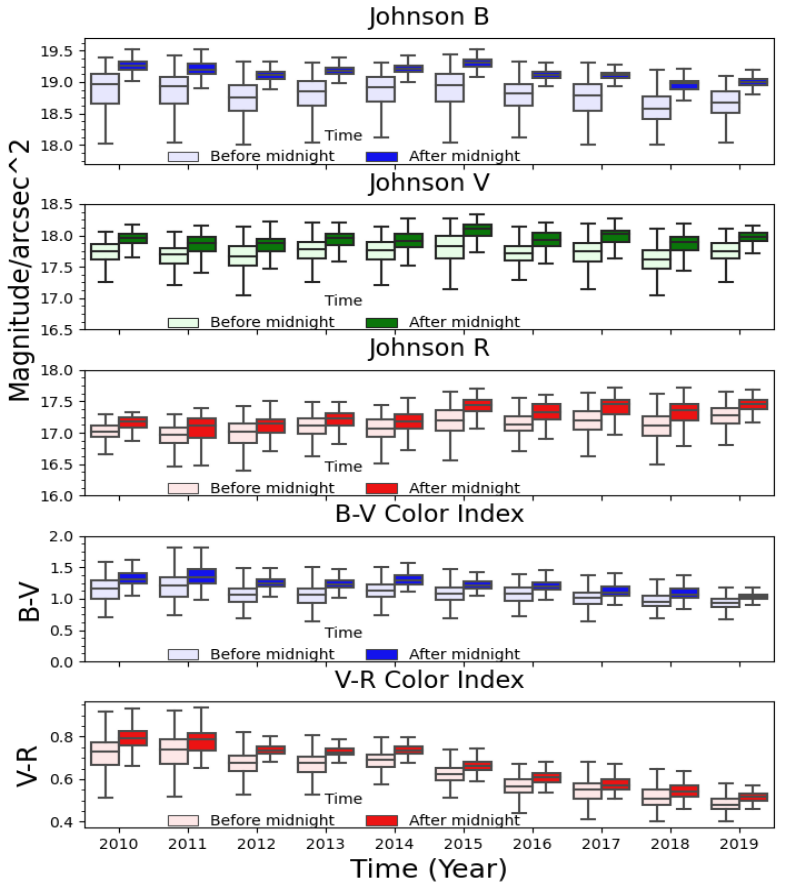
Figure 22. Median trends of the Johnson B, V, and R photometric bands and the associated B-V and V-R color indices before and after midnight.